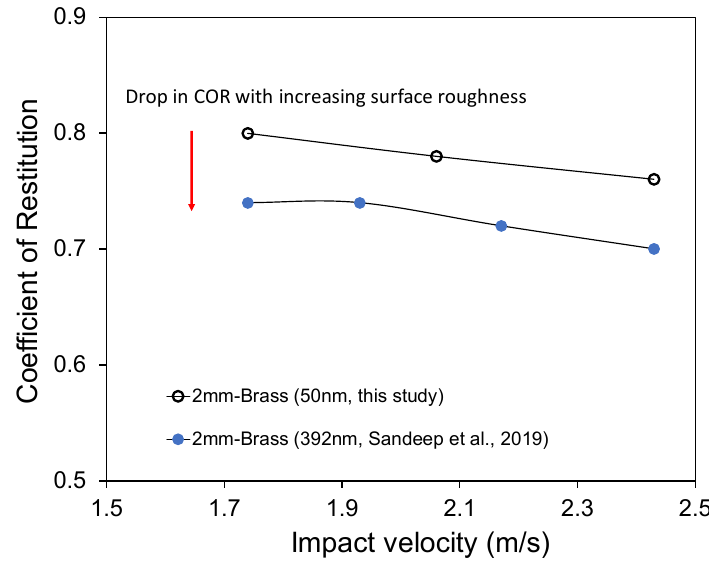
Figure 7. Variation of the coefficient of restitution with surface roughness of brass block.